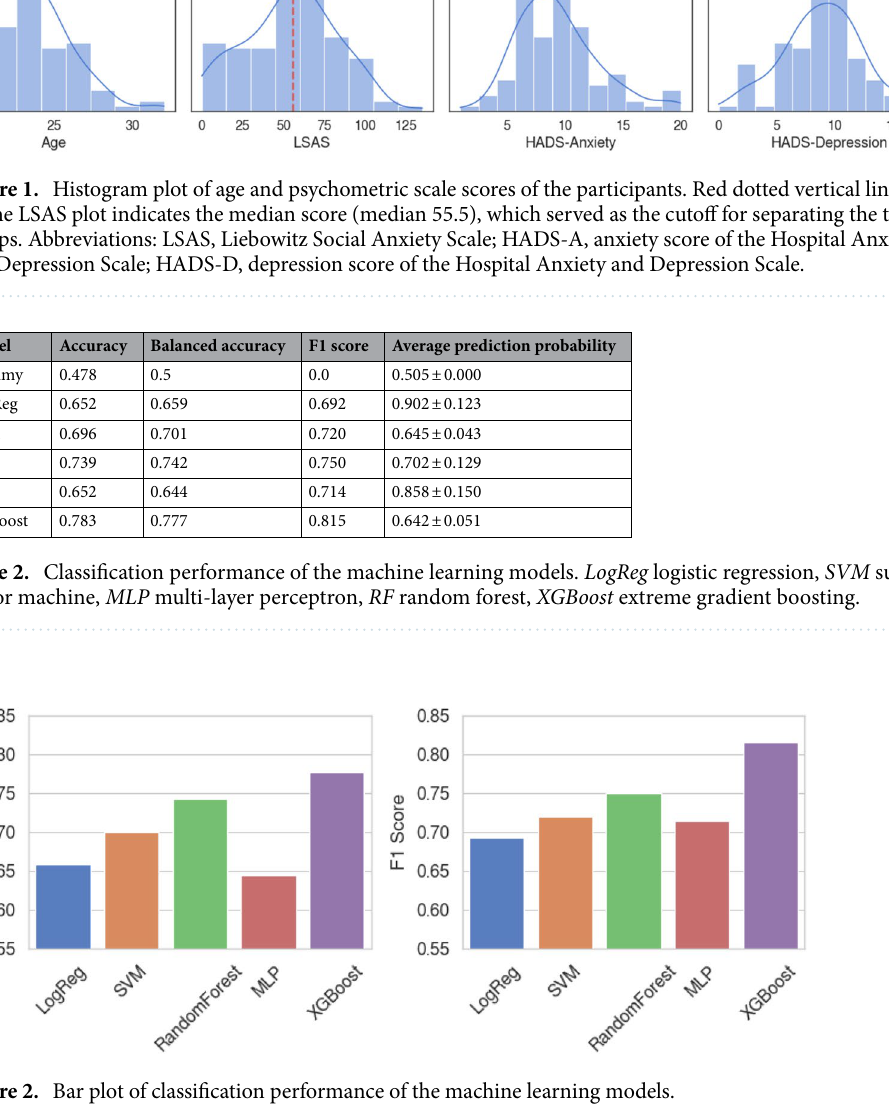
Figure 2. Bar plot of classification performance of the machine learning